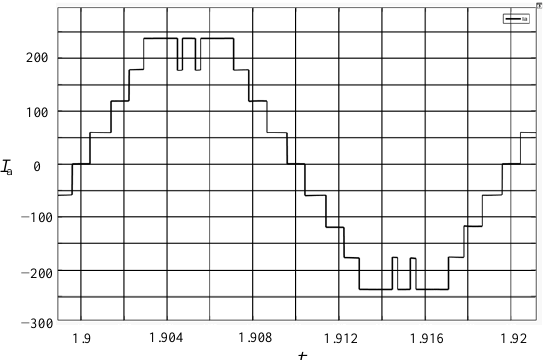
Fig. 11. The instantaneous value of 24-pulse rectifier input current with PWM.